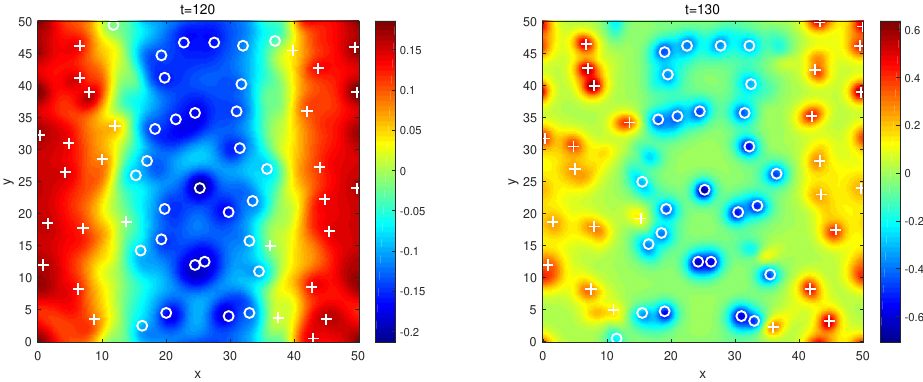
Figure 7. Density plots of the magnetic fields and the locations of the singular points of the order parameter phases (i.e. the locations of the centers of the vortices) at two specific times t = 120 (left) and t = 130 (right) in the far-from-equilibrium state with τ Q = 20 and B 0 = 1 . Colorful regions represent the magnitudes of the magnetic fields, while the plus signs and the circles indicate the positions of the positive and negative vortices,